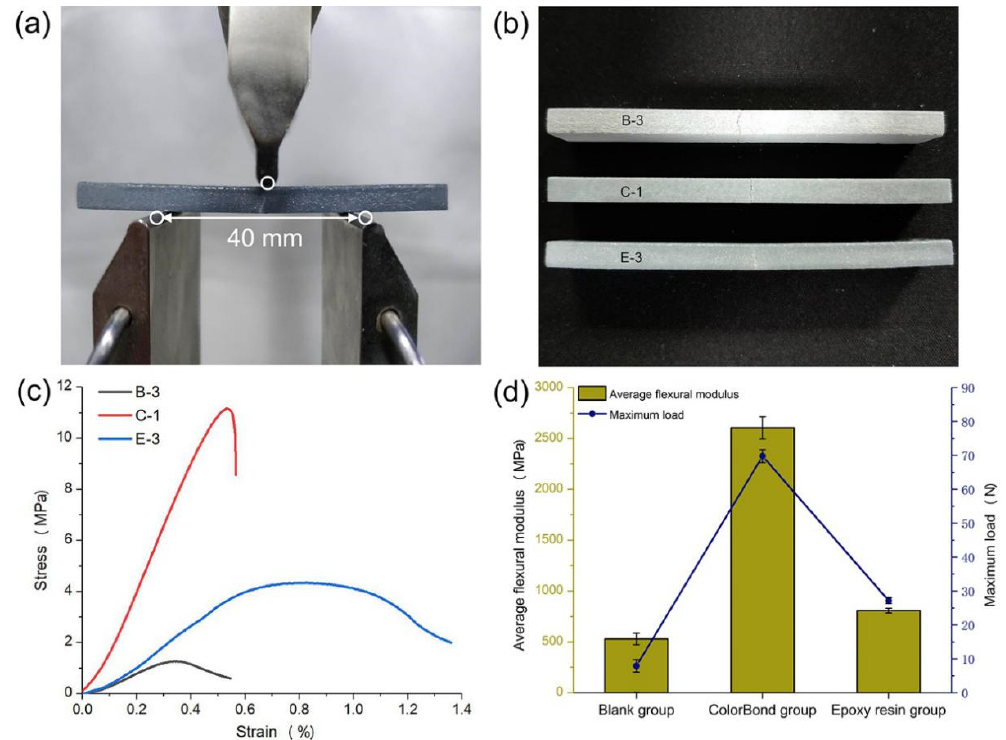
Figure 2. Flexural tests of specimens subjected to three impregnating process. ( a ) Flexural testing device; ( b ) Image of flexural failure specimens; ( c ) Stress-strain curves of three-point flexural test; ( d ) Bending-related properties measurements.